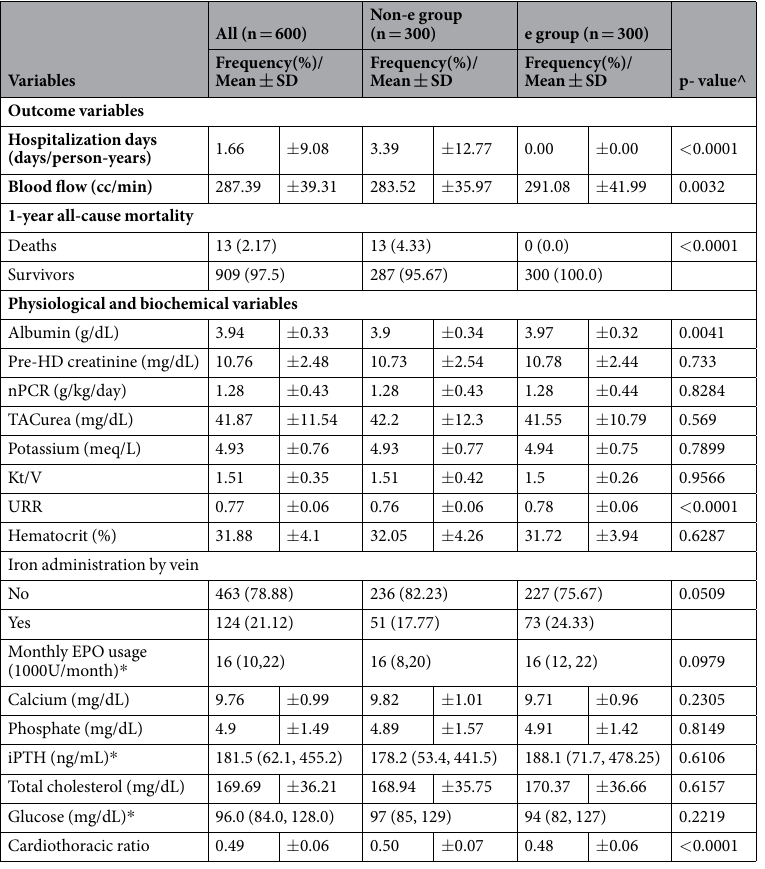
Table 3. Clinical characteristics and outcomes associated factors of the study patients one year after the e-intervention. e group: e-intervention group; non-e group: non-e-intervention group; HD: